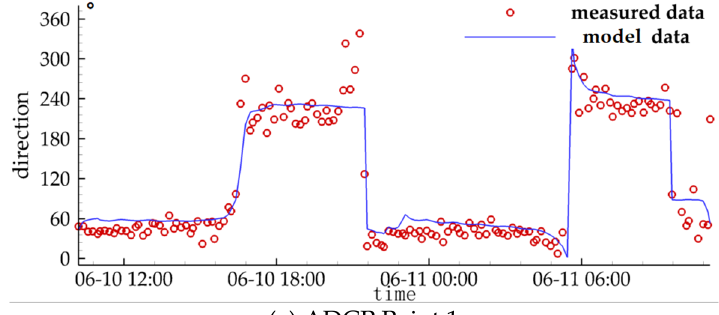
Figure 4. Velocity validation.